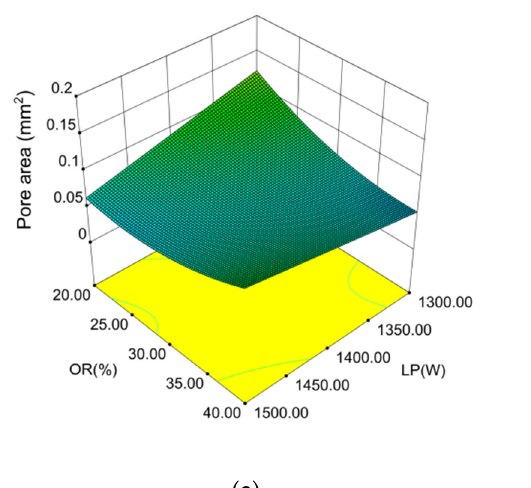
( b ) Figure 8. ( a ) Residual plot of the pore area; ( b ) Comparison of predicted and actual pore area. As shown in the response surface and its contour line in Figure 9a,b, when increasing the laser power and overlap ratio, the pore area displayed a trend of decreasing at first and then increasing afterwards. With the increased laser power, the energy received by the molten pool increased, which enhanced the convection effect and prolonged the life of the molten pool. Under this circumstance, the height of the cladding zone reduced due to the flattening tendency in the molten pool on the curved substrate caused by gravity, which shortened the distance for the bubbles escaping from the bottom [24]. Meanwhile, with the broadening on the overlap ratio, the overlapping area between the adjacent two cladding tracks was increased, which enhanced the second-time heat effect. The second-